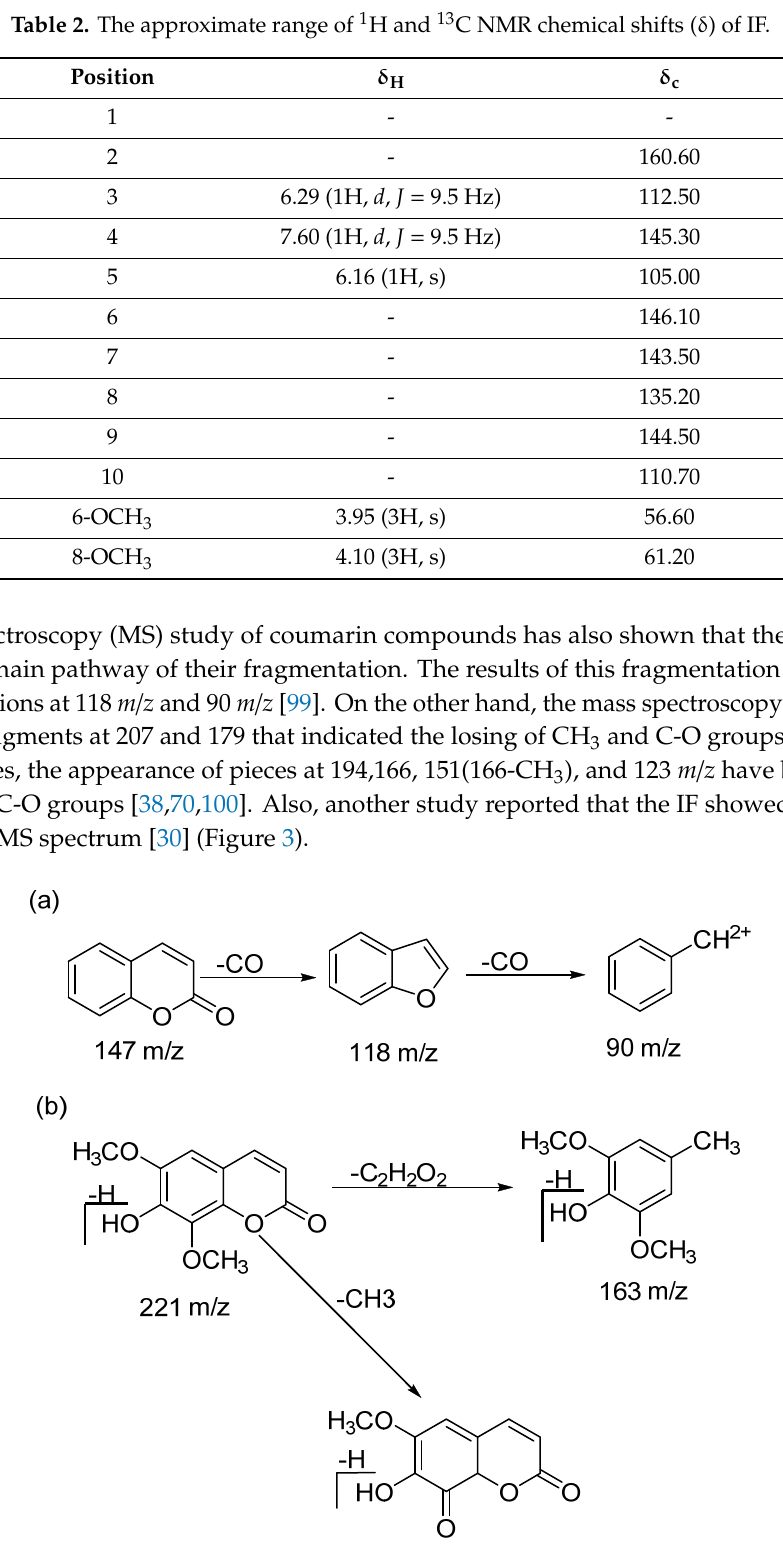
Table 2. The approximate range of 1 H and 13 C NMR chemical shifts ( δ ) of IF.